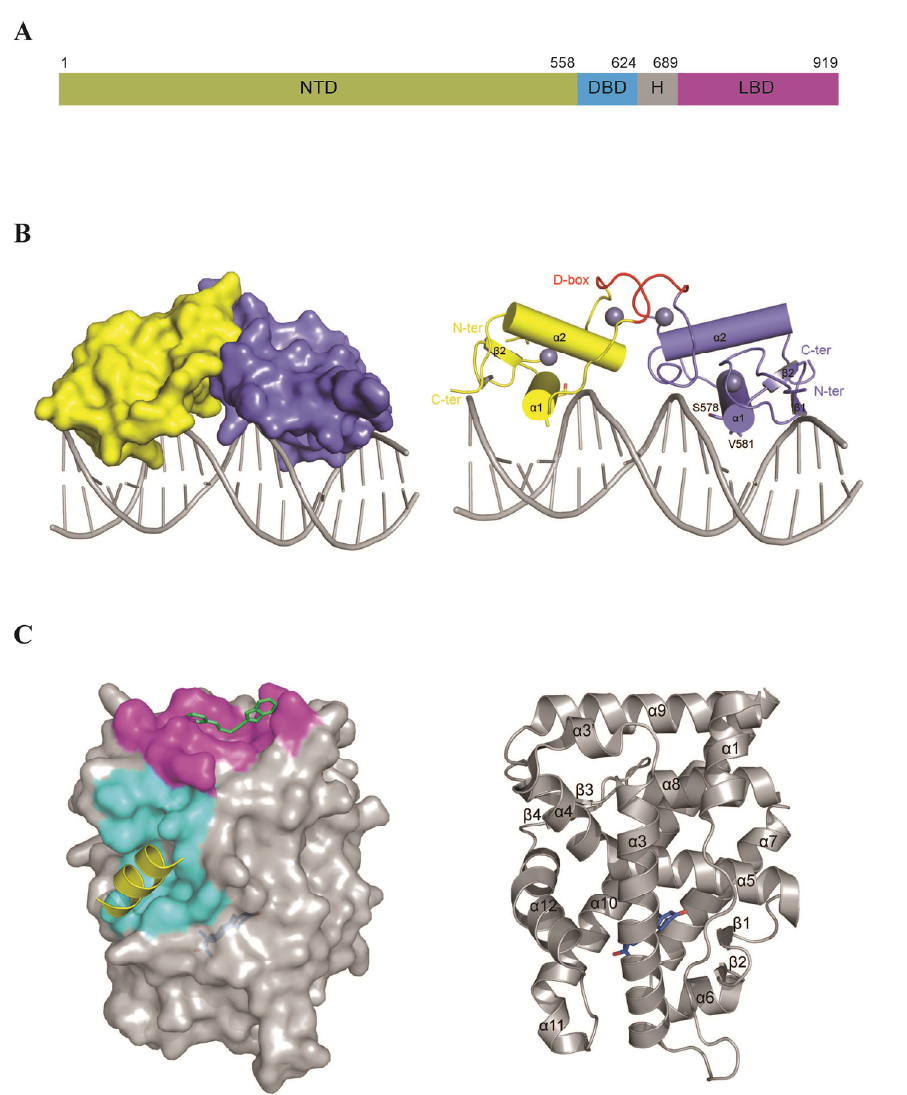
Figure 2. Domain organization and available structures of the androgen receptor. ( A ) Scheme of the domain organization of the AR: NTD ( N -terminal domain), DBD (DNA binding domain), H (hinge region) and LBD (ligand binding domain). Residue numbers above the scheme delineate the domain boundaries; ( B ) Surface ( left ) and cartoon ( right ) representations of the rat AR-DBD structure. Zinc ions are presented as grey spheres, and the D-box of each DBD monomer is highlighted in red. Residues of the P-box involved in DNA recognition are shown as sticks; ( C ) Surface ( left ) and cartoon ( right ) representations of the human AR-LBD structure: surfaces highlighted in cyan and magenta correspond to AF2 and BF3, respectively. The cartoon representation in yellow corresponds to a coactivator bound to AF2, and the stick representation in green depicts a BF3 small molecule inhibitor. R1881, a synthetic androgen, bound to the androgen binding site, is shown in